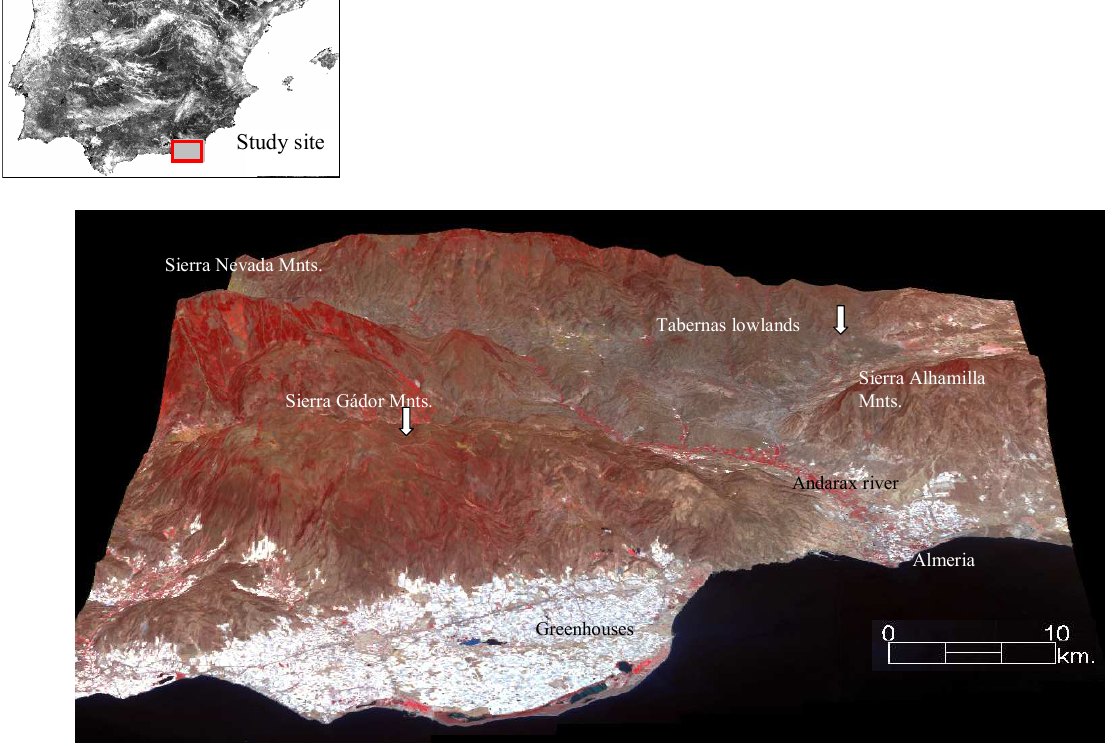
Figure 1. Study site in southeast Spain (Almería). The large image shows a 3D surface with elevation, and ASTER RGB false-color composite (15 m) taken on July 18, 2004. Three mountain ranges are visible: part of the Sierra Nevada, part of the Sierra Alhamilla and the Sierra de Gádor. White arrows show the location of the two research sites: Llano de los Juanes in the Sierra de Gádor and Rambla Honda in the Tabernas